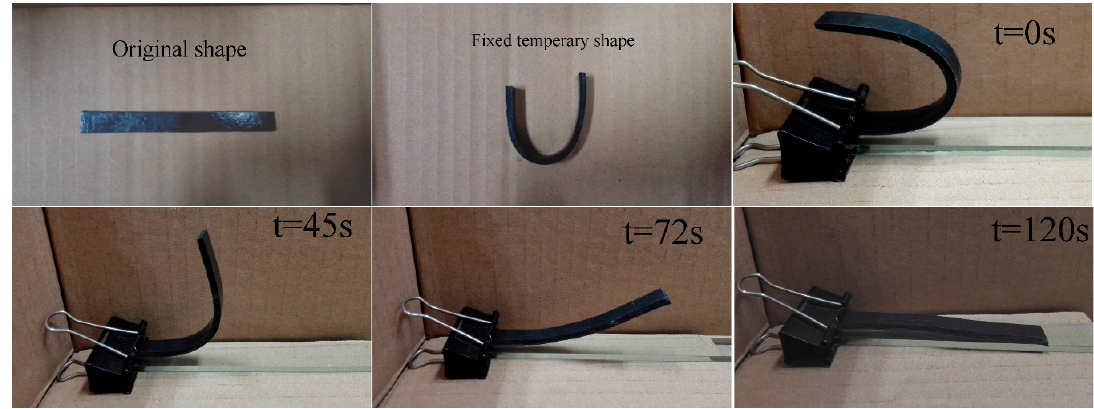
Figure 8. The shape recovery process of the sample with 1.0 wt % graphene in a 55 °C oven.